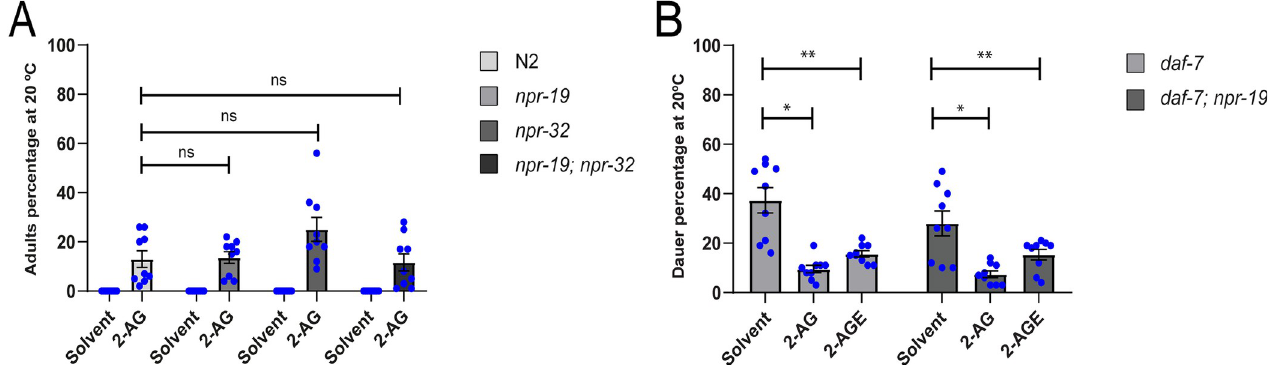
Fig 2. Endocannabinoids stimulate transport of cholesterol by employing pathways independent of npr-19 and npr-32 . (A) 2-AG suppresses L2 � larval arrest of npr-19 , npr-32 and npr-19; npr-32 animals grown for two generations on plates containing 0 μ g/ml of cholesterol. All values are from n = 3 independent experiments shown as Mean ± SEM. ns = not significant. N2 is the C . elegans wild-type strain. (B) Endocannabinoids suppress dauer arrest of daf- 7 and daf-7; npr-19 grown on plates containing 5 μ g/ml of cholesterol. Mann-Whitney rank sum test, � p < 0.001, �� p < 0.001. All values are from n = 3 independent experiments are shown as Mean ± SEM. The concentration of 2-AG was 50 μ M and of 2-AGE 100 μ M.